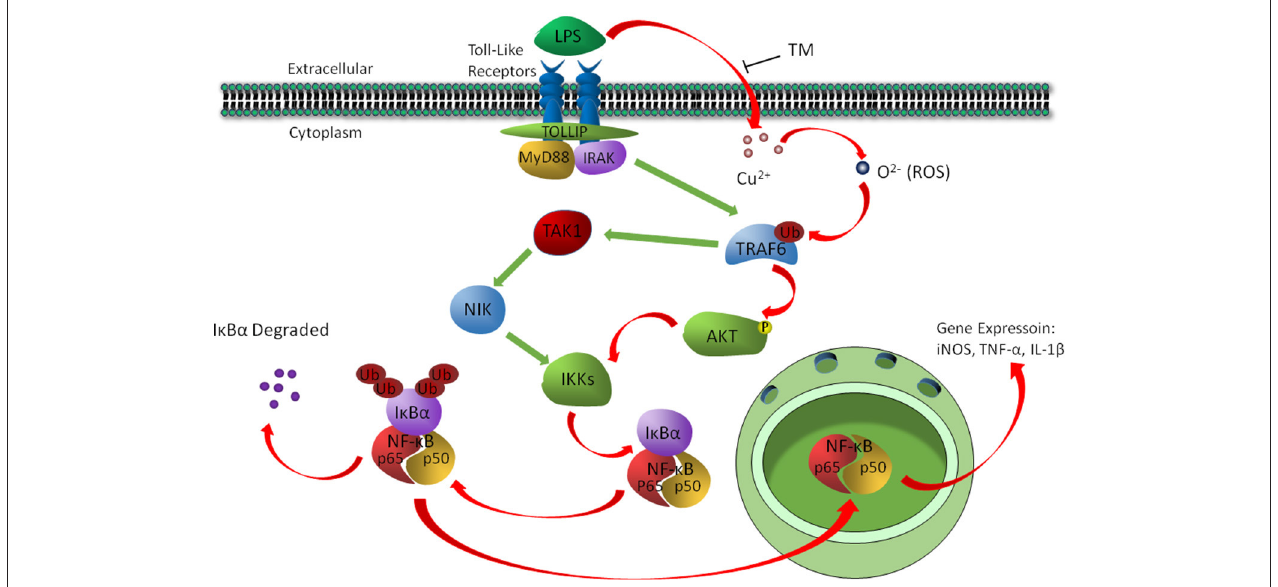
FIGURE 7 | The schematic diagram shows that TM suppressed the secretion of NO, TNF- α , and IL-1 β by reducing the bioavailability of copper and the activity of its downstream ROS/TRAF6/AKT/NF κ B signaling pathway.